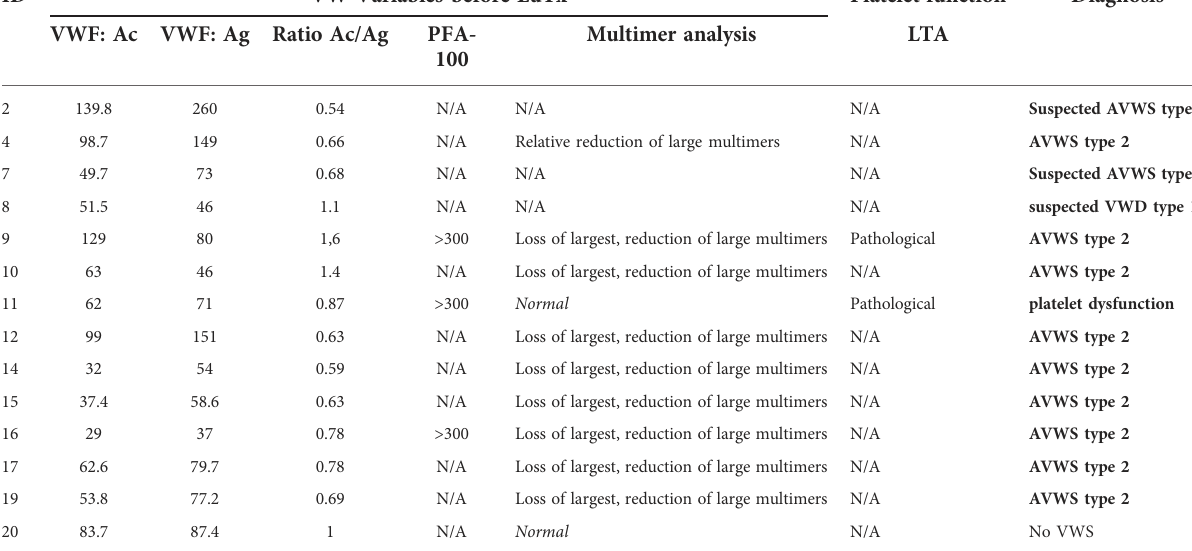
TABLE 2 Results: laboratory results and hemostaseological diagnosis.